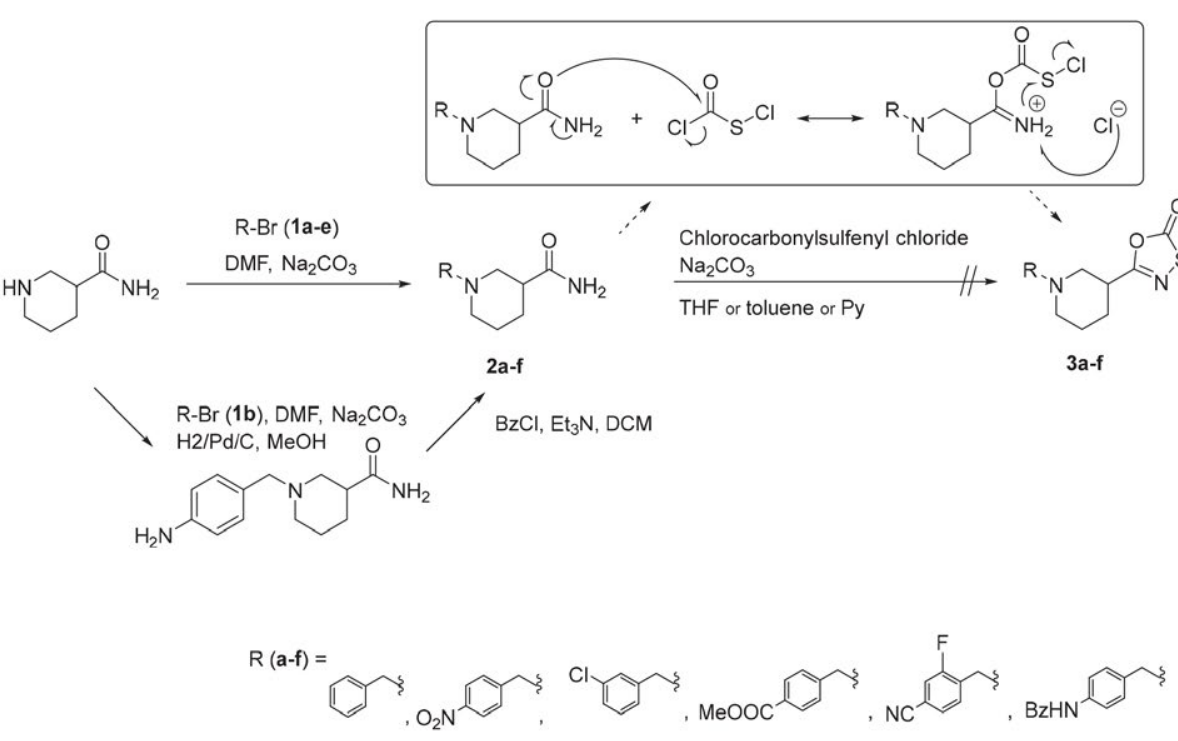
Figure 4. Cyclization of piperidine carboxamides towards final piperidin-3-yl-oxathiazol-2-ones.